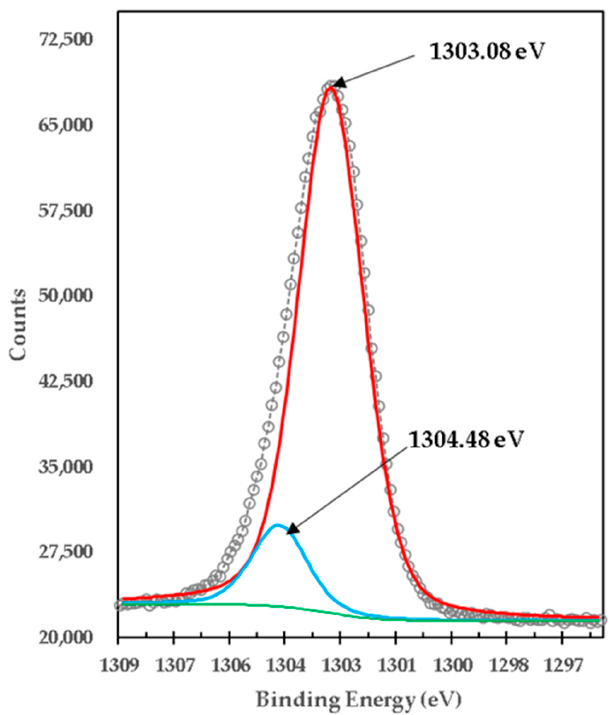
Figure 9. XPS high-resolution spectra of Mg1s in calcined brucite at 1100 °C for 1 h M2.